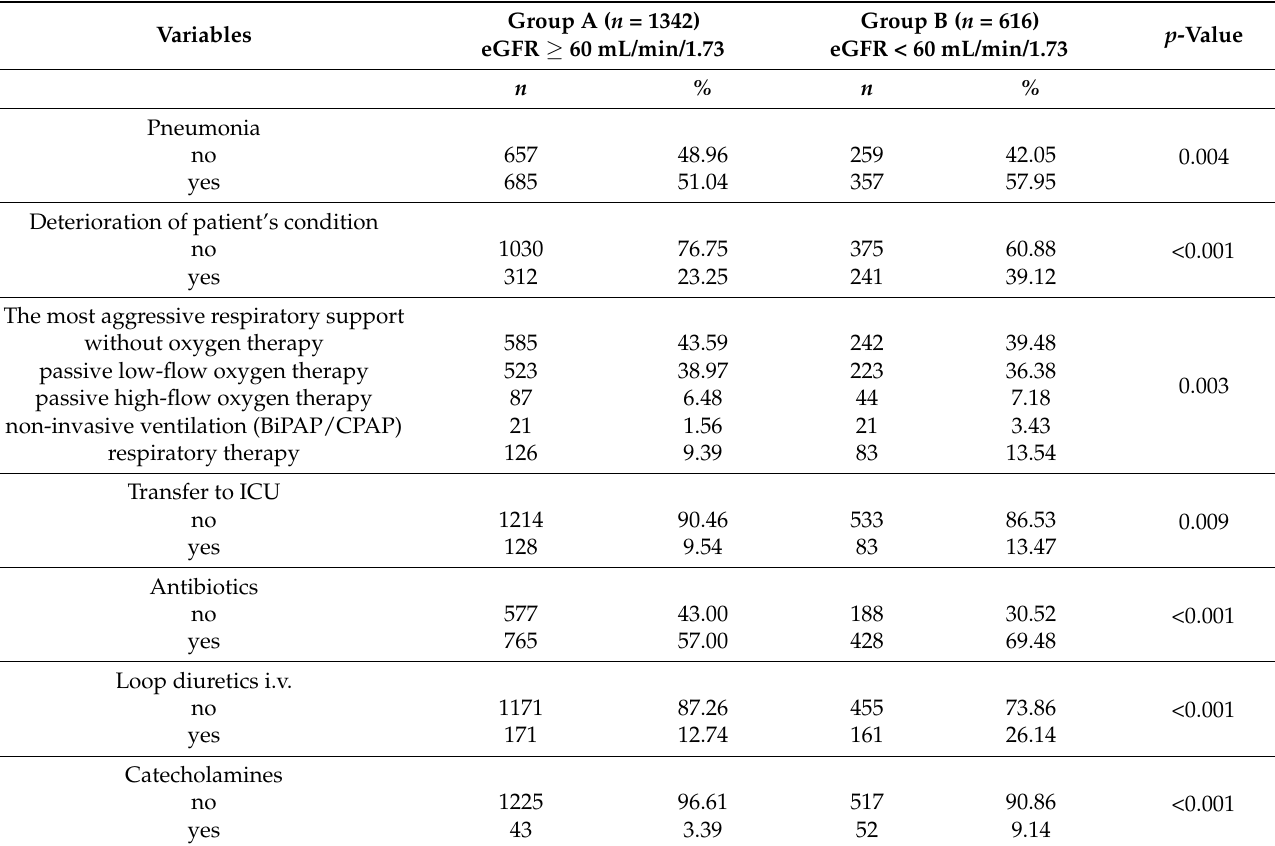
Table 5. Comparison of clinical parameters during hospitalization between two groups of COVID-19 patients.